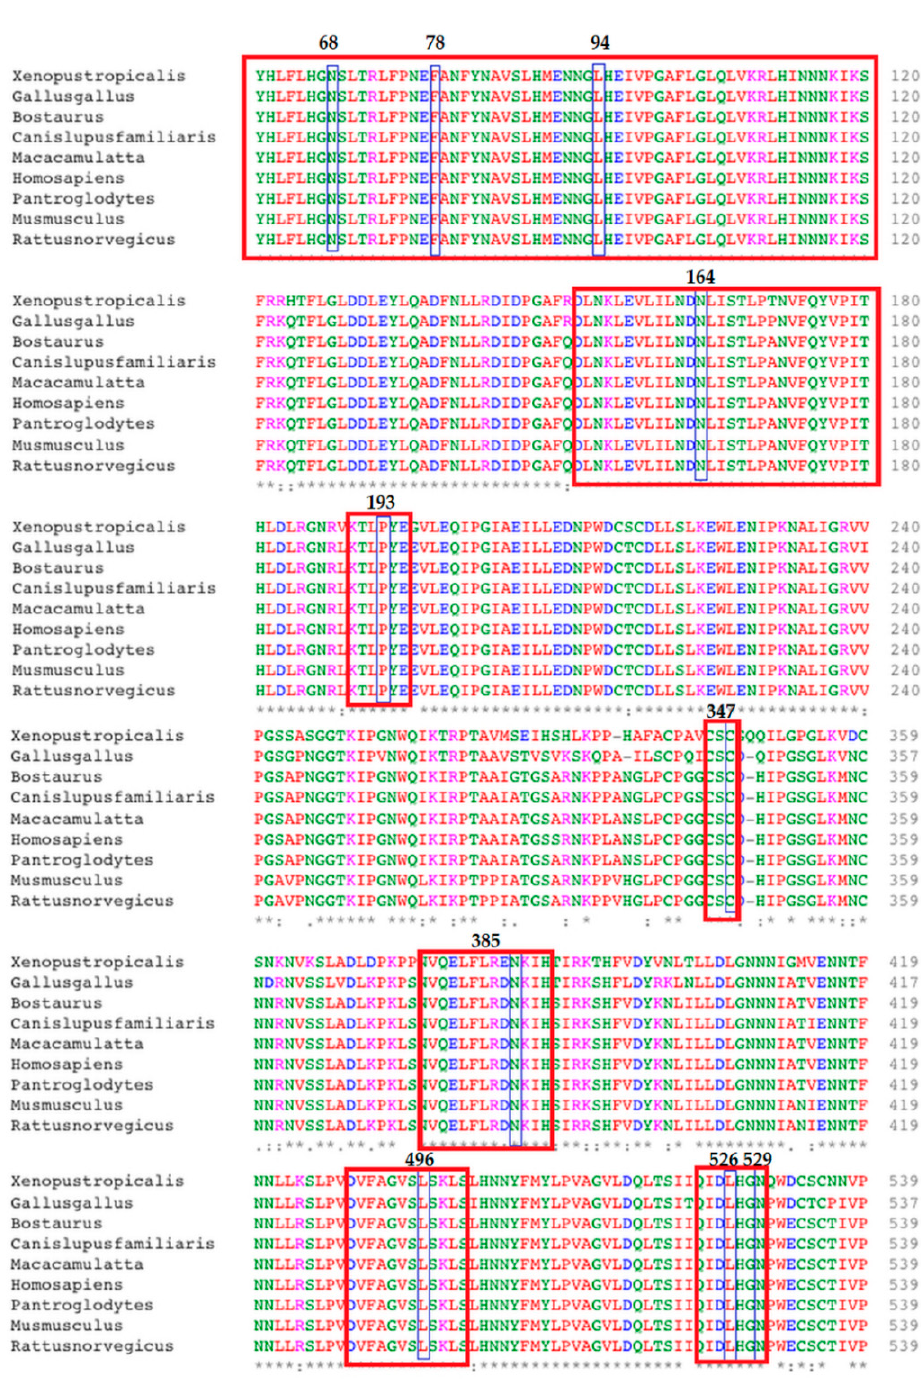
Figure 3. Amino acid conservation analysis using Clustal Omega. Note: Conserved regions harboring the SNP of interest are highlighted by the red box.